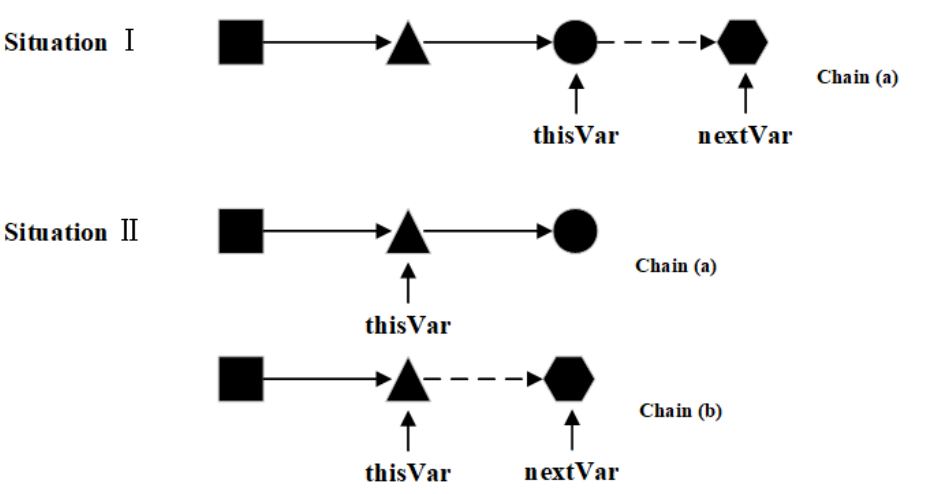
Figure 3. Taint propagation chain. Chain (a) consists of square triangles and circles, and the hexagon (nextVar) is the newly inserted node. In Situation II, chain (b) is generated from chain (a)’s header to thisVar, and then the new node (nextVar) is inserted into chain